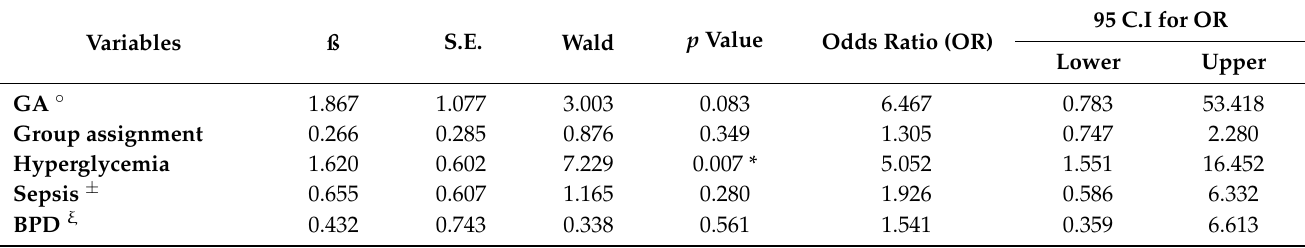
Table 5. Binary logistic regression analysis to evaluate the influence of covariates on the occurrence of mortality.